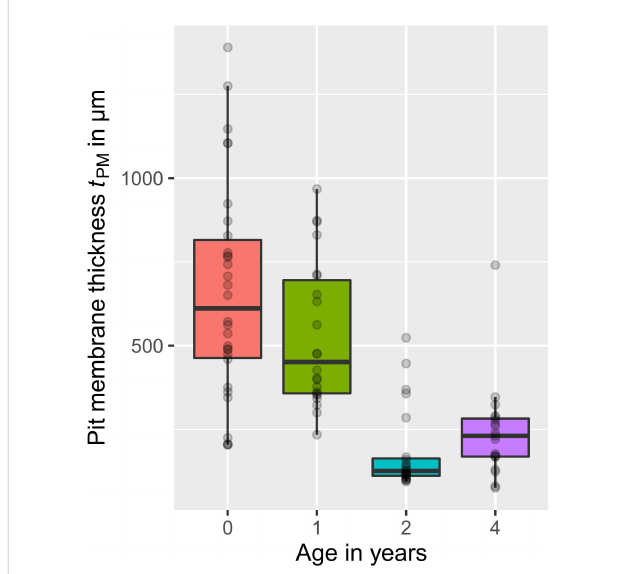
(cid:1) values of d PM resh, never dried pit membranes) and mber .